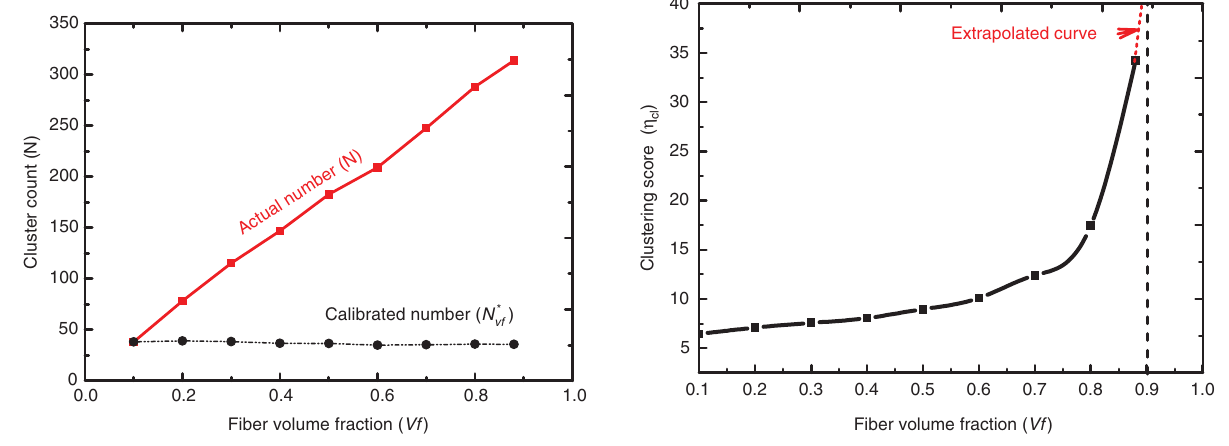
Figure 13: Cluster count vs. volume fraction graph for ran- domly packed arbitrary samples taken at percolation threshold ( Ψ = Ψ ̅ = 0.7071) and calibration curve post normalization